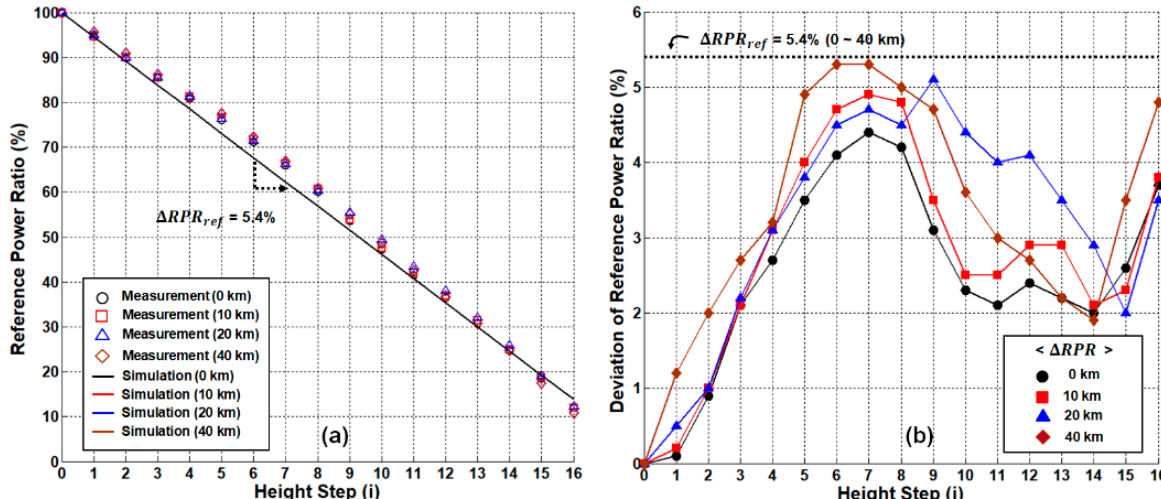
Figure 10. System performance of dual-path network configuration. ( a ) Measured/simulated reference-to-power ratios according to the sensing distance. ( b ) Allowable deviation ranges of the reference-to-power ratios for remote sensing.